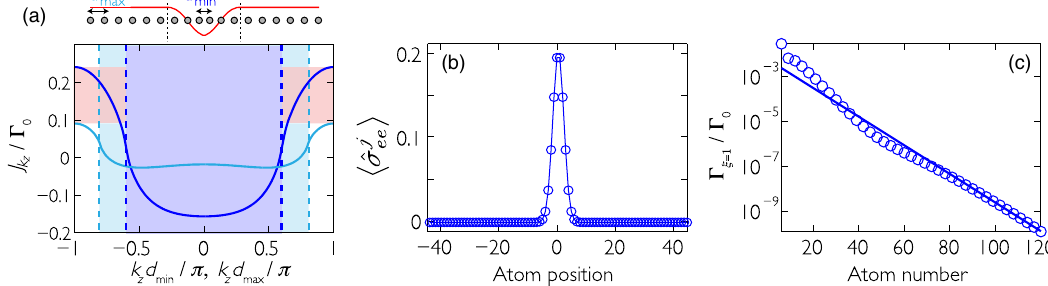
FIG. 8. Cavity in an atomic chain with slowly varying lattice constant. The chain along ˆ z is divided into three regions: in the left and right regions, the lattice constant d is uniform and equal to d (a) Dispersion relation for two infinite lattices with constant d of the corresponding lattice constant). The light line is indicated by the vertical dashed lines with the same color. A bandwidth of frequencies (shaded pink) emerges wherein propagating modes exist for lattice constant d resonances to form within the nonuniform chain. An illustration of the chain is shown (top), where the red line represents how the lattice separation changes along the chain. (b) Excited-state population versus atom position corresponding to the fundamental mode in the cavity, illustrated for N ¼ 90 atoms. (c) Decay rate of the fundamental mode versus atom number, showing an exponential suppression. = λ 0 ¼ 0 . 4 and atomic polarization along the chain We choose d max